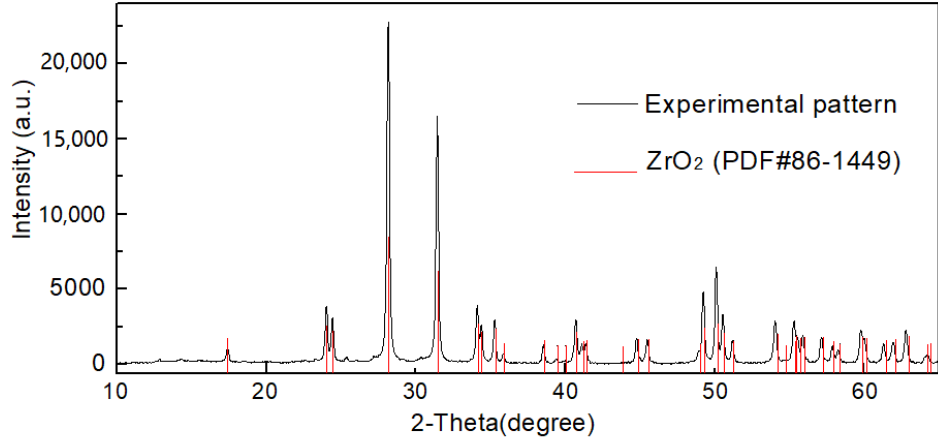
Figure 13. XRD pattern of the ZrO 2 prepared from the basic zirconium sulfate precipitate.